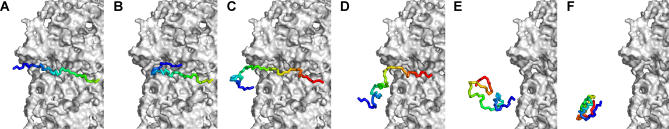
A Coupled Synthesis–Folding Simulation of CI2Snapshots from a typical de novo folding simulation of CI2 in the presence of the ribosome (grey surface). The nascent chain is colored from blue (N-terminus) to red (C-terminus). Snapshots (A–F) are for timepoints 3.6 μs, 4 μs, 6 μs, 6.04 μs, 6.08 μs, and 6.23 μs, respectively; the length of the nascent protein in (A) and (B) is 40 and 44 residues, respectively, in all other panels, it is full length. This figure was prepared with PyMOL [95].